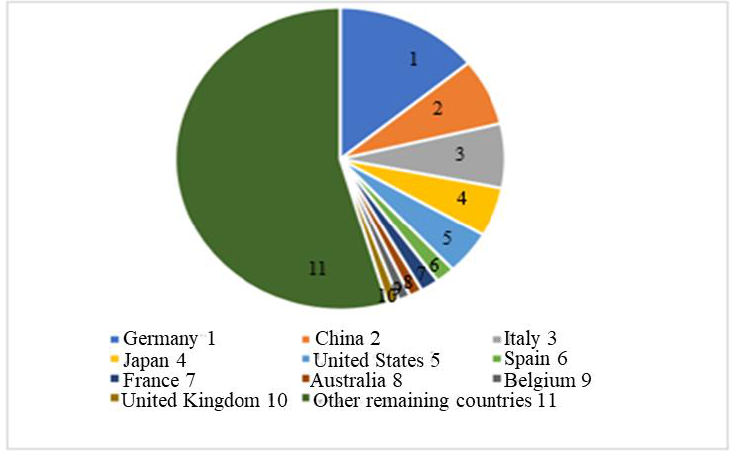
Figure 7. Cumulative-installed PV capacity in ten leading countries and other remaining countries of the world, [99].